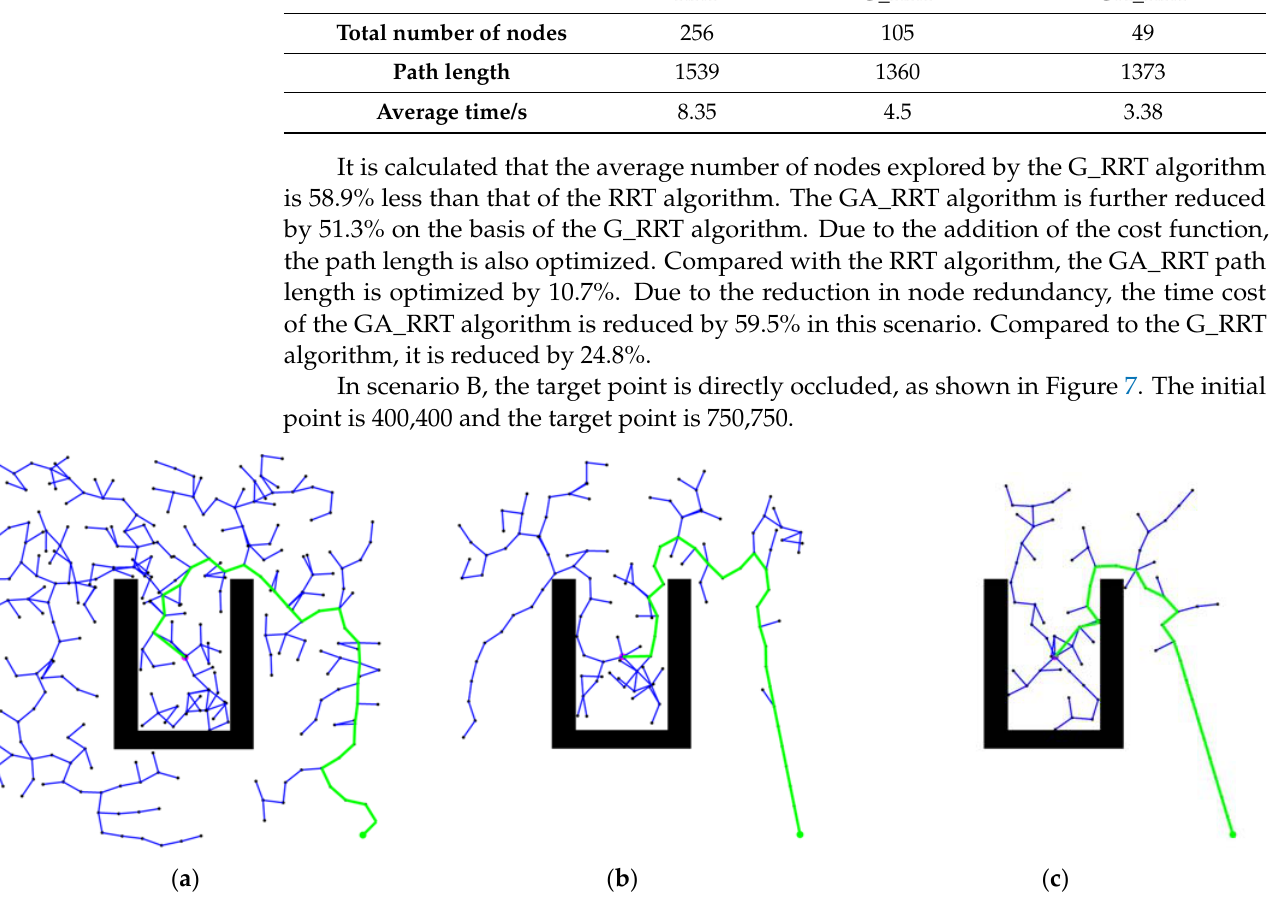
Table 2. The average experimental data for Scenario A.